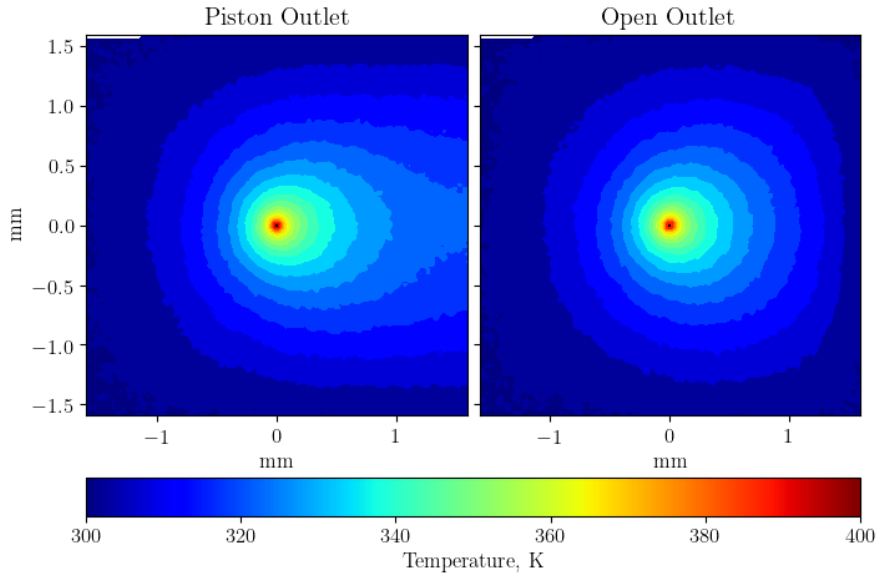
Figure 2. Simulation results for temperature distribution around the wire using a piston outlet boundary condition ( left ) and an open outlet boundary condition ( right ). All other boundaries are